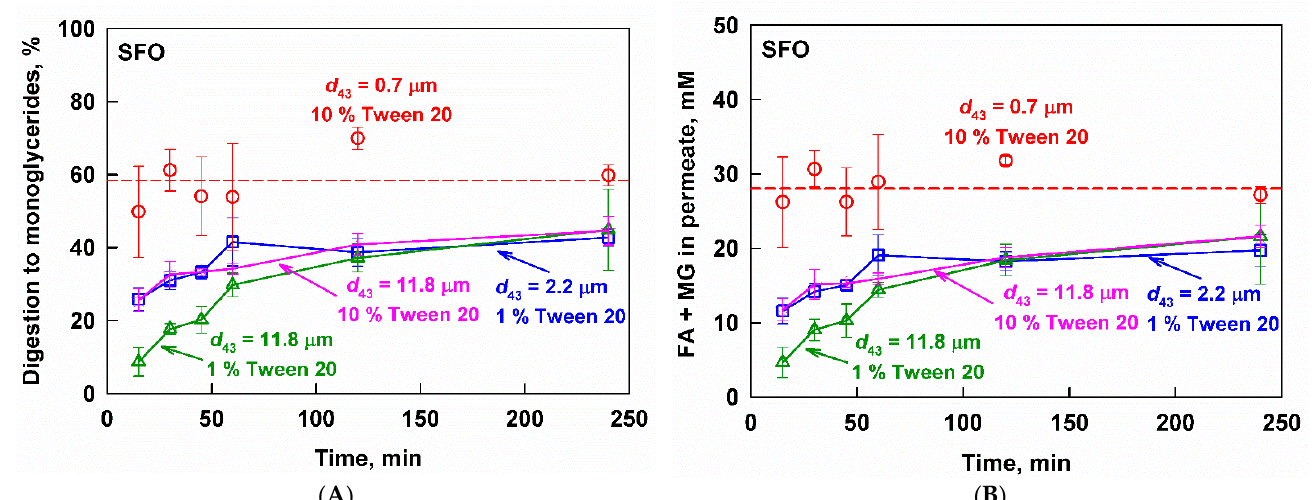
Figure 4. ( A ) Digestion and ( B ) fatty acids (FA) and monoglycerides (MG) measured in the aqueous phase after filtration of fenofibrate-loaded SFO emulsions with d 43 = 0.7 µm (10 wt% emulsifier, red circles), d 43 = 2.2 µm (1 wt% emulsifier, blue squares), d 43 = 11.8 µm (10 wt% emulsifier, pink stars) and d 43 = 11.8 µm (1 wt% emulsifier green triangles) as a function of time at simulated intestinal conditions.